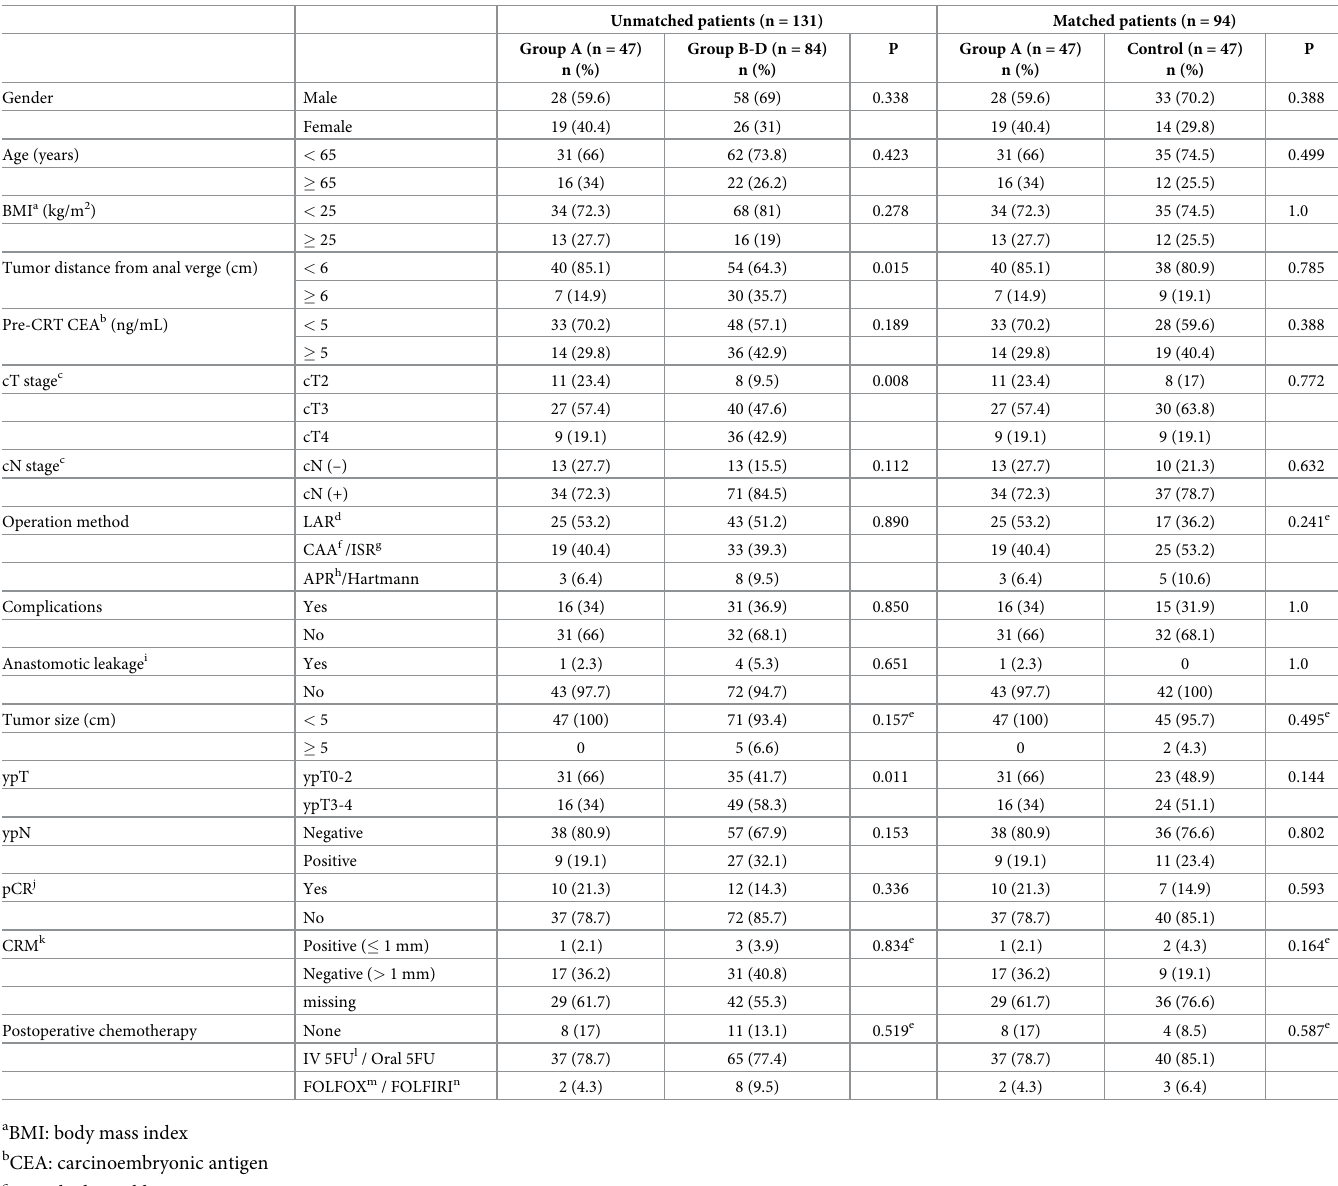
Table 2. Patients’ characteristics according to combination of pre and post-chemoradiotherapy neutrophil-to-lymphocyte ratio before and after propensity score matching